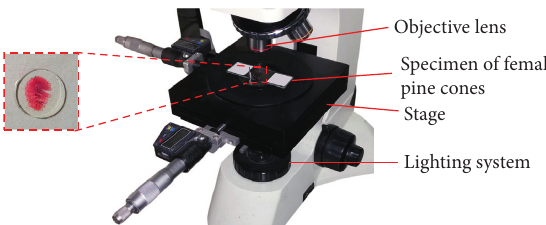
Figure 4: Experimental observation